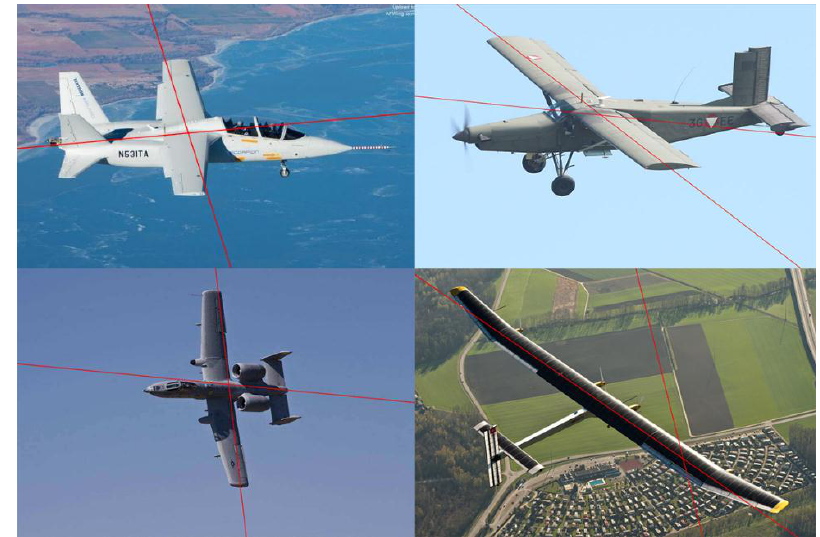
Figure 9. Some incorrect results from our structure extraction algorithm.